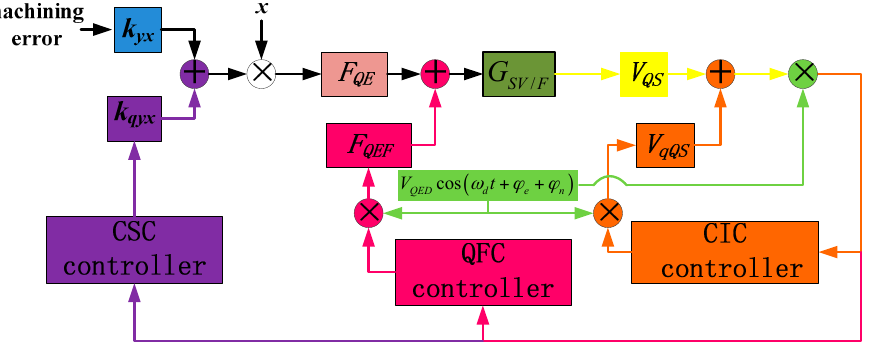
Figure 5. Diagram of quadrature error generating process and correction method.